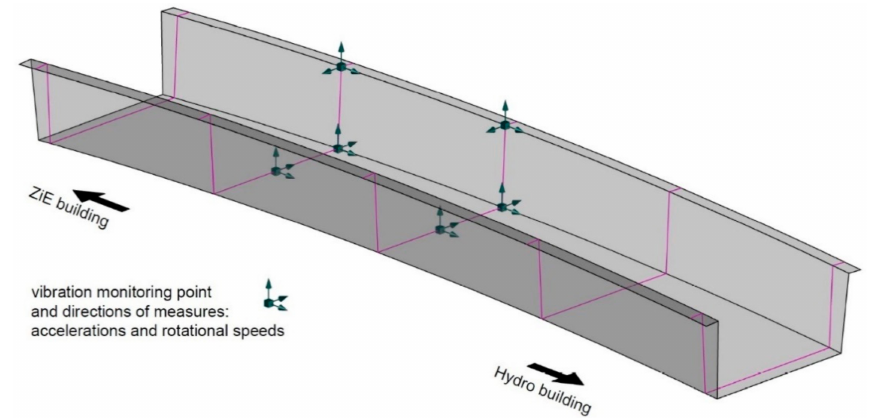
Figure 12. Location of vibration monitoring